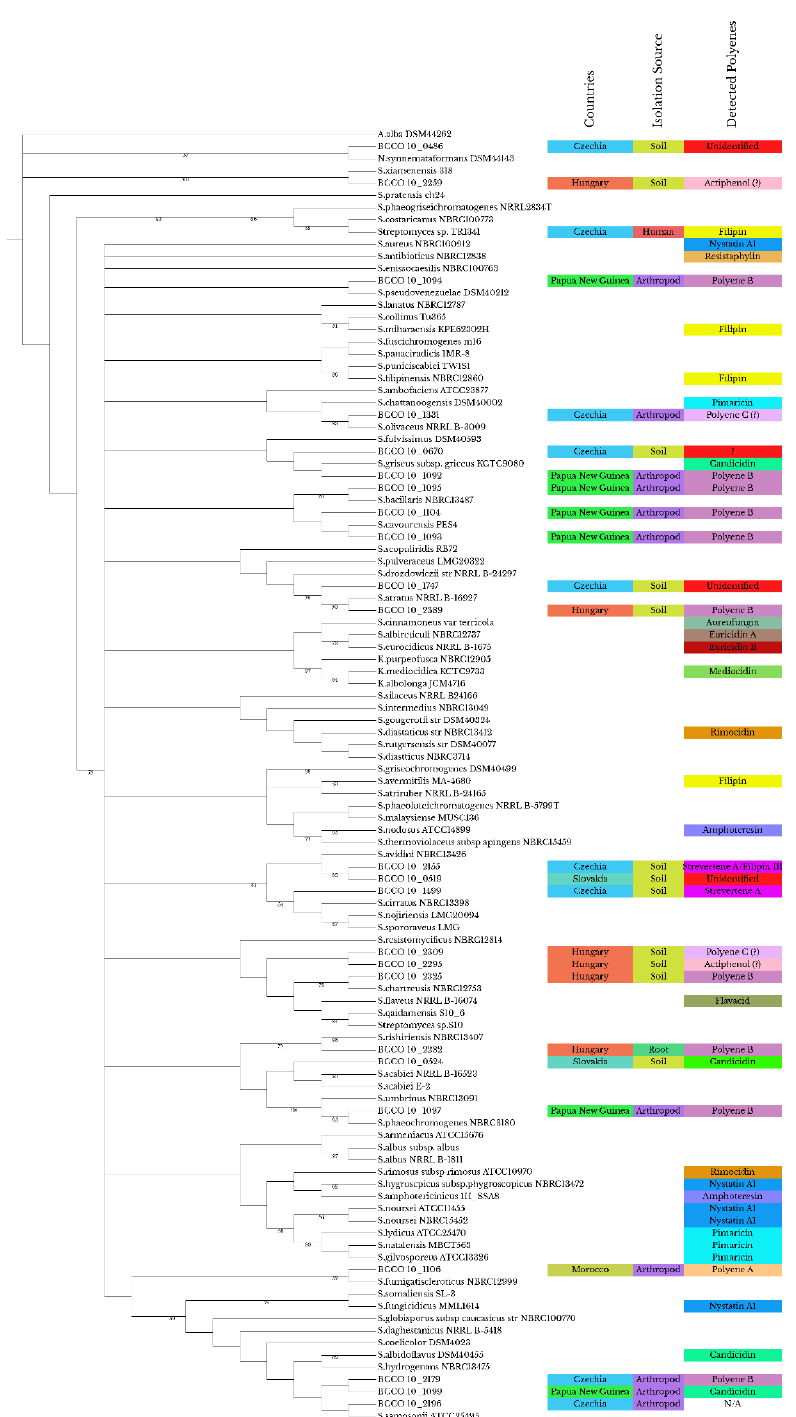
Figure 1. Phylogeny of Streptomyces strains involved in the study inferred from 16S rRNA gene similarity . Color codes represent the type of a polyene produced by the strain, the isolation source, and the country of origin. Only bootstraps above 50 are shown. The question mark indicates metabolites detected in a co-culture. The sequences of type strains closely related to the sequences of known polyene producers and BCCO strains were included to support topography of phylogenetic tree. The strains were selected according to Labeda et al. [96]. Abbreviations: A.– Amycolatopsis , N.– Nocardioides , S.– Streptomycces